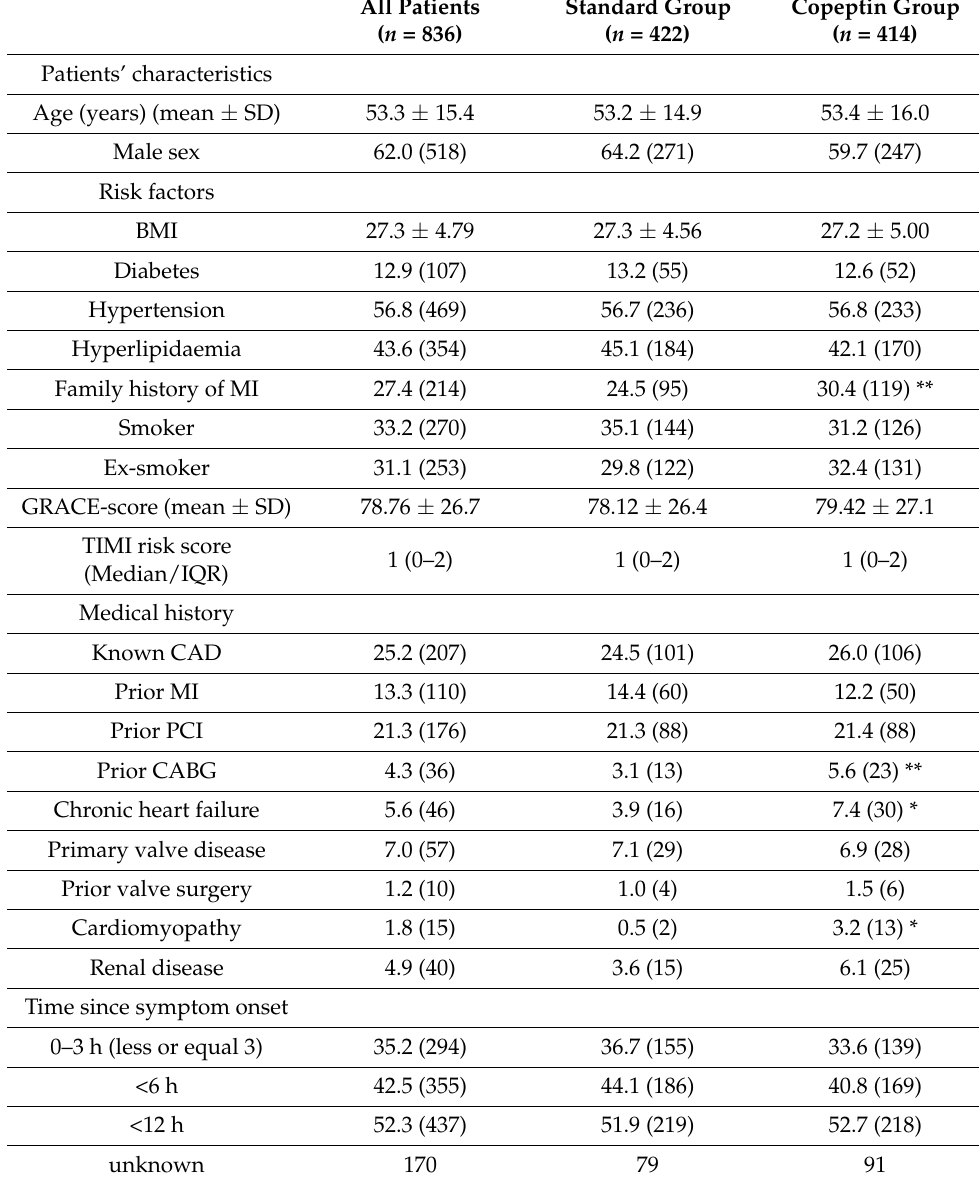
Table 1. Characteristics of all patients and in the